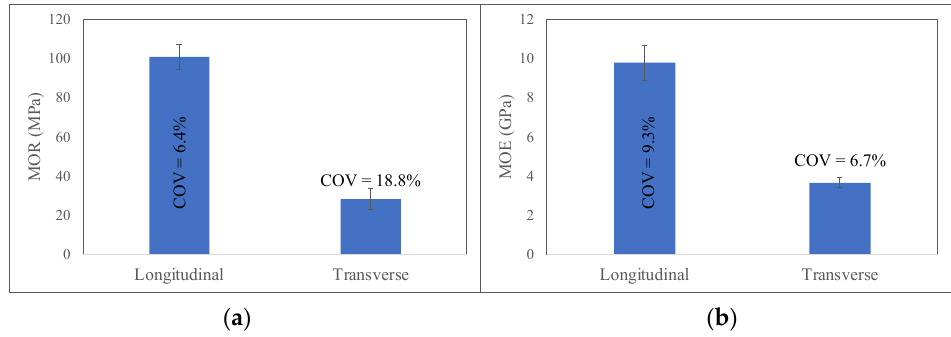
Figure 11. Moisture absorption and thickness swell properties of CRTM panels (MC2 and TS2 refer to the moisture absorption and thickness swell values after 2 h; and MC24 and TS24 after 24 h).